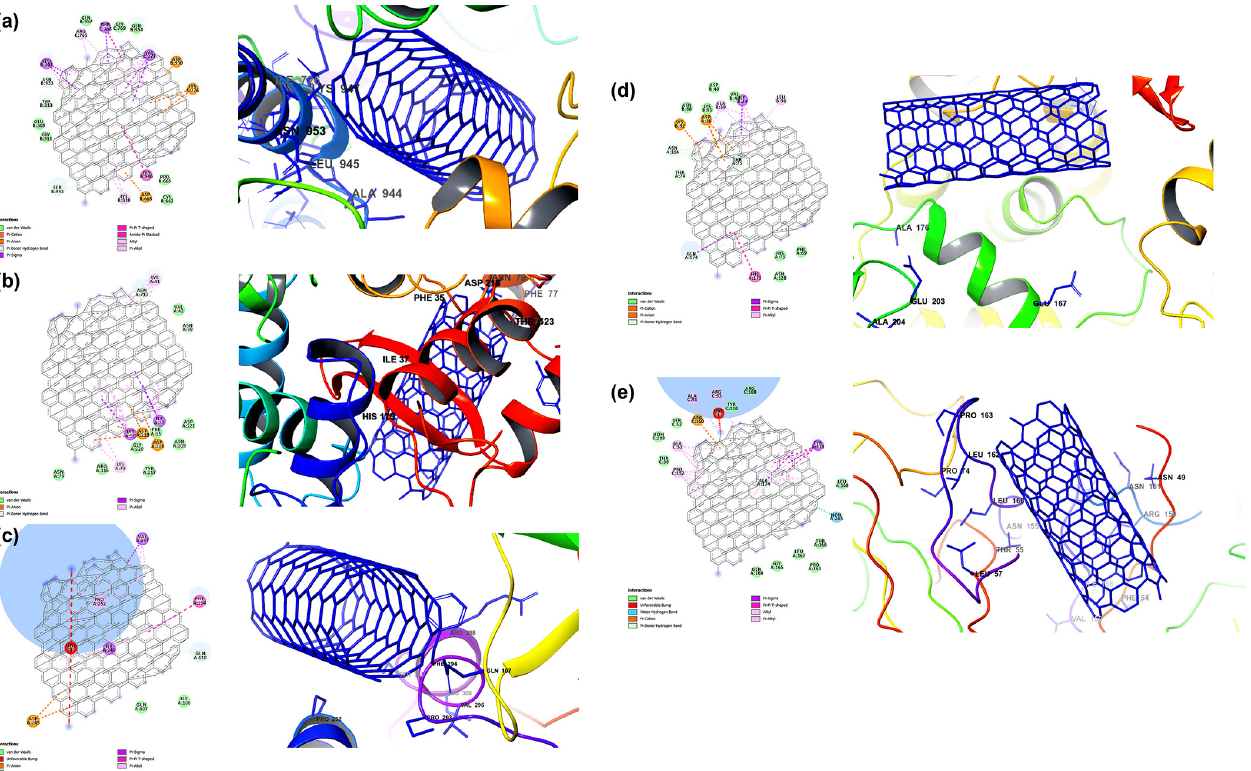
Figure 11. Molecular docking outcomes concerning the interaction potential of carbon nanotubes towards the following targets of SARS-CoV-2: ( a ) spike glycoprotein, ( b ) RdRp, ( c ) Mpro, ( d ) papain- like protease and ( e ) RNA-binding domain of nucleocapsid protein. Figure reprinted from Ref. [168] under the terms of the Creative Commons CC-BY-NC-ND